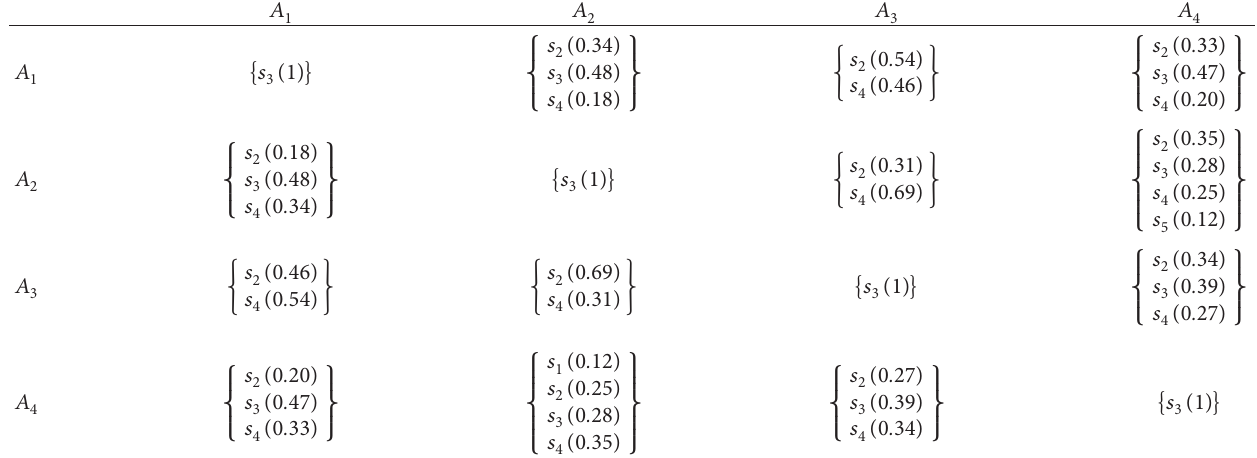
Table 3: The revised hesitant fuzzy probabilistic linguistic preference